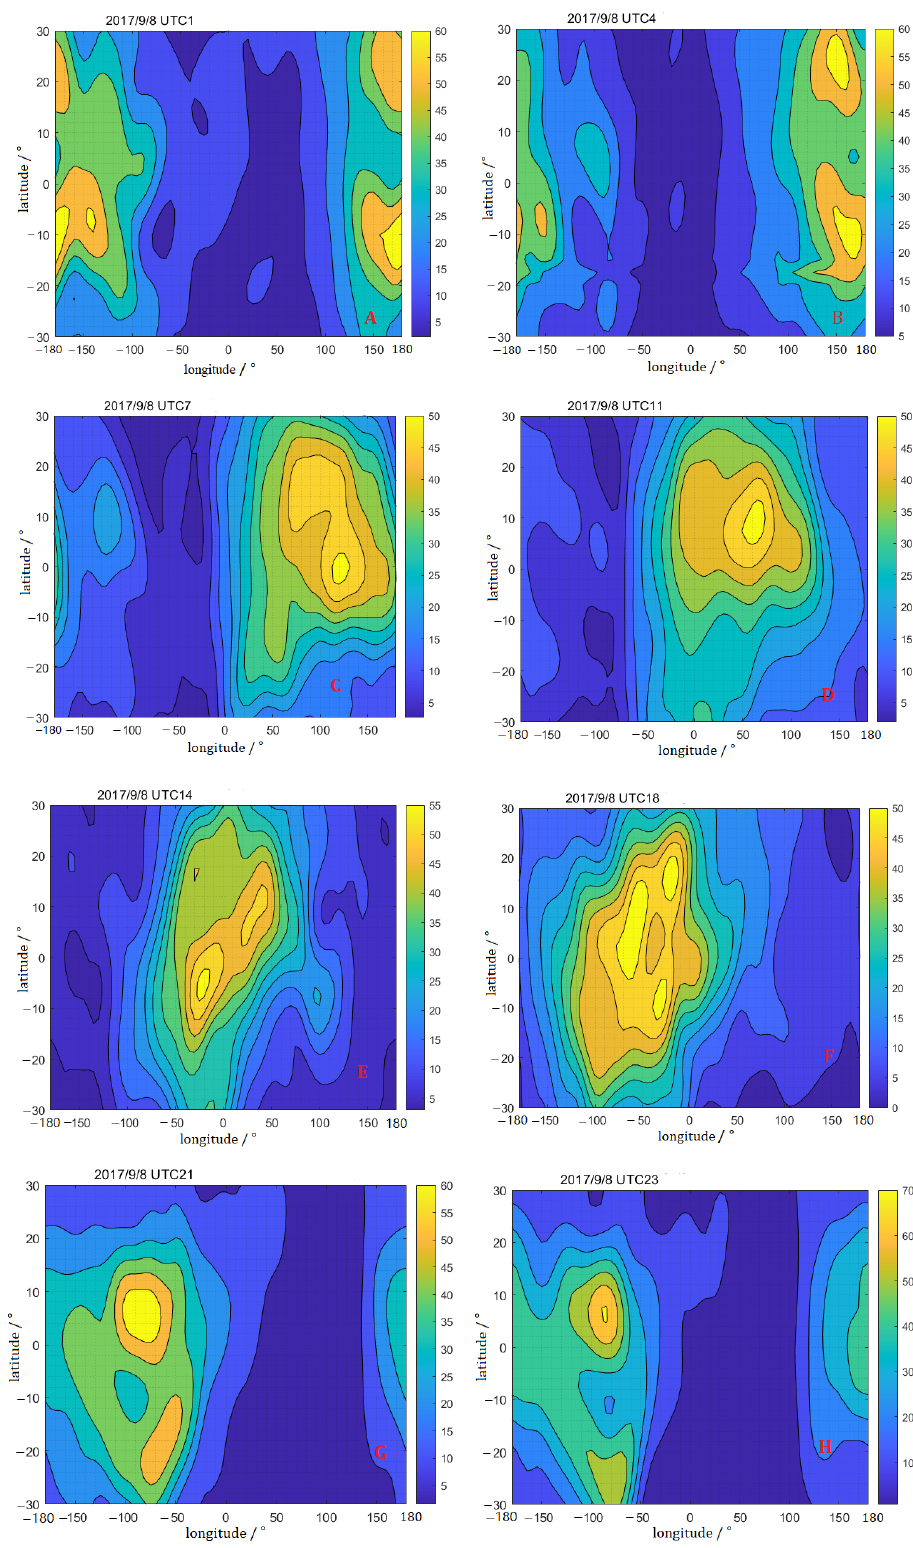
Figure 11. Spatial distribution of low-latitude VTEC during the strong geomagnetic storm. Panels ( A – H ) show the VTEC spatial distribution at UTC 1:00, UTC 4:00, UTC 7:00, UTC 11:00, UTC 14:00, UTC 18:00, UTC 21:00, and UTC 23:00 on 8 September 2017, respectively. unit: TECU.